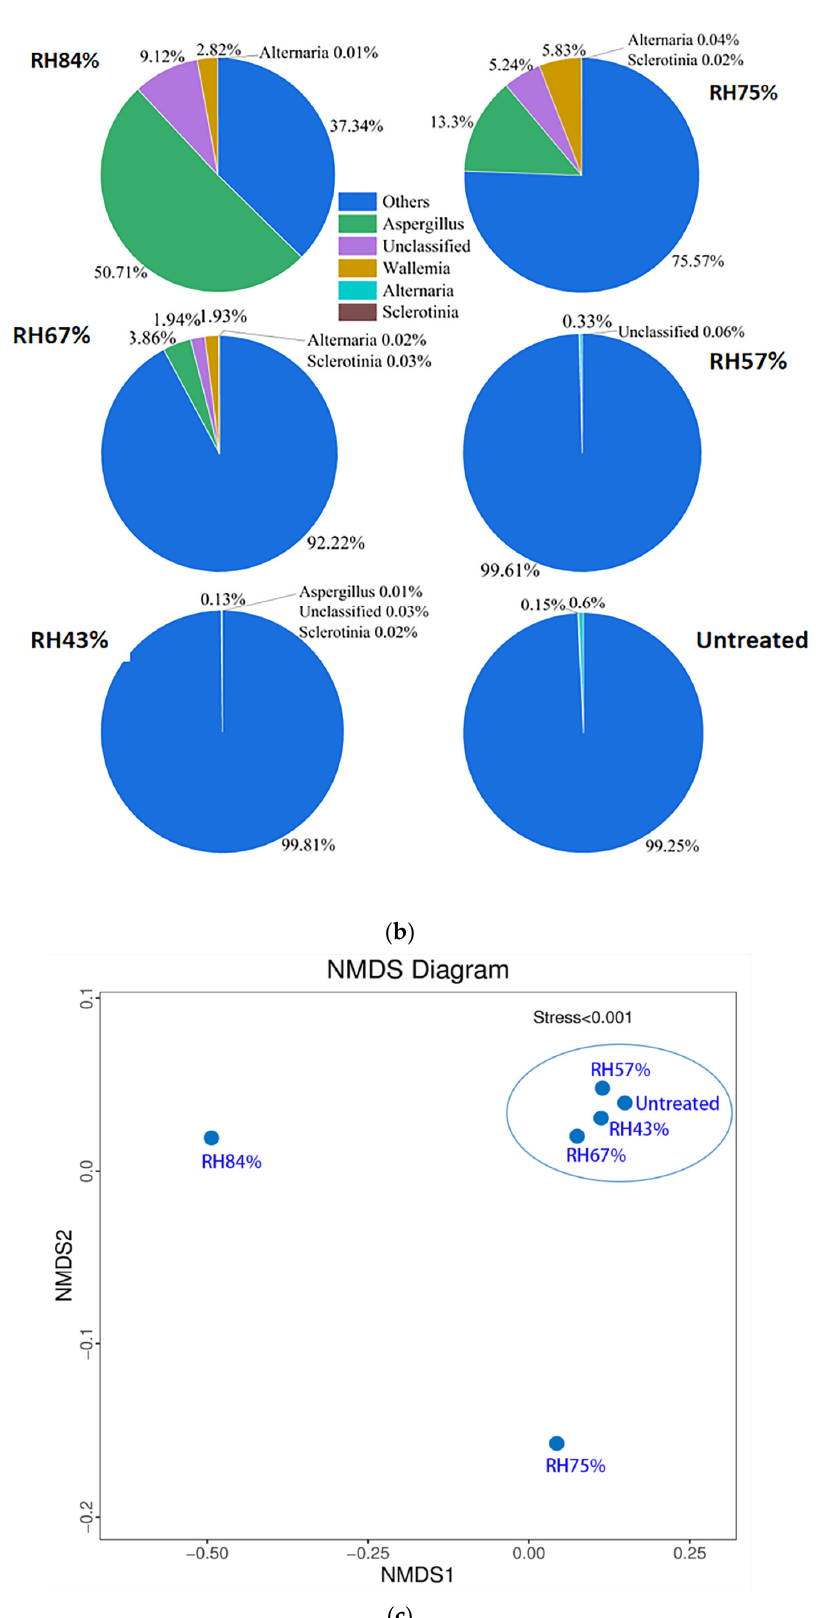
Figure 9. The effects on unmildewed sunflower seed kernels exposed to various levels of relative humidity (RH) for six months. (Untreated: unmildewed post-harvest kernels) ( a ) Kernel